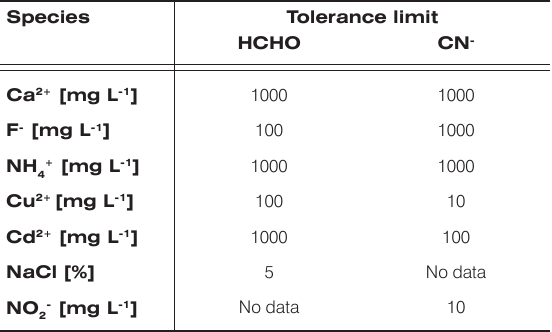
The calculated F determinedin nasal discharge samples are presented in